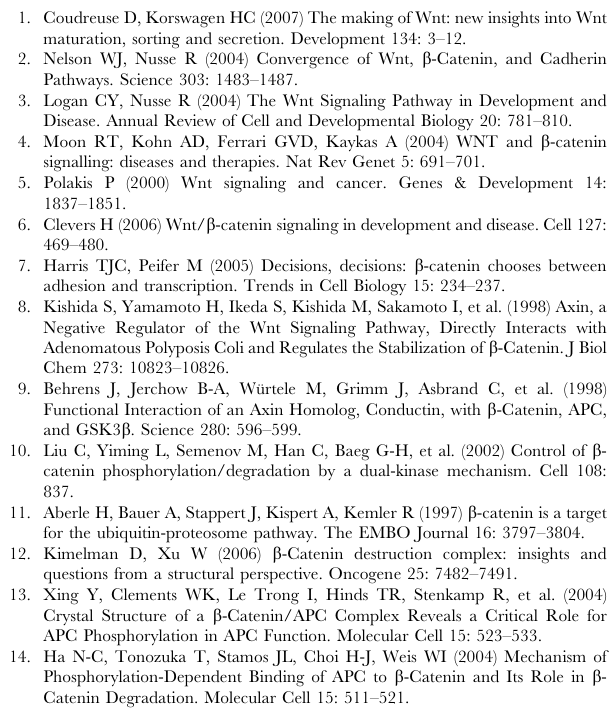
ii–v are grayscaled for visual clarity. Figure S11 Sub-cellular distribution of ‘‘active’’ b - catenin in mammalian cells. (A) Compartment concentra- tions of ‘‘active’’ b -catenin in HEK293T, Caco-2, MDCK, SW480 and SW480APC cells. (B) Percentage distribution of ‘‘active’’ b -catenin for the five cell lines. (TIF) Figure S12 Cell population sizing and selection (HEK293T). Population statistics of HEK293T, showing the (A) histograms of normalised volume (Calcein AM/Hoechst); (B) Scatter plot of fluorescent marked volumes (Calcein AM vs. Hoechst) showing a good linear relationship; (C) Scatter plot of fluorescent marked volumes (Calcein AM vs. Hoechst) showing population isolation and the cut-off volumes applied. Figure S13 Cell population sizing and selection (MDCK). Population statistics of MDCK, showing the (A) histograms of normalised volume (Calcein AM/Hoechst); (B) Scatter plot of fluorescent marked volumes (Calcein AM vs. Hoechst) showing a good linear relationship; (C) Scatter plot of fluorescent marked volumes (Calcein AM vs. Hoechst) showing population isolation and the cut-off volumes applied. Figure S14 Cell population sizing and selection (Caco- 2). Population statistics of Caco-2, showing the (A) histograms of normalised volume (Calcein AM/Hoechst); (B) Scatter plot of fluorescent marked volumes (Calcein AM vs. Hoechst) showing a good linear relationship; (C) Scatter plot of fluorescent marked